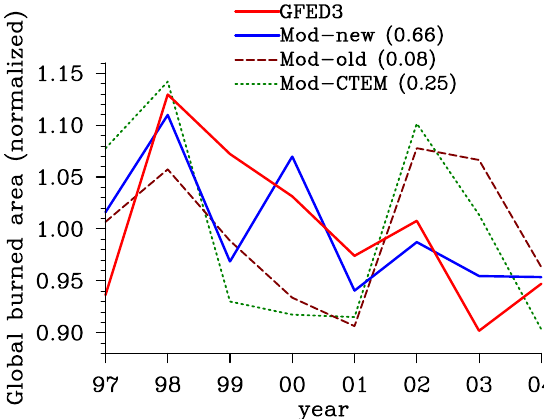
Fig. 13. Annual global burned area normalized by the mean for 1997–2004 from GFED3 and CESM1 simulations with different fire parameterizations. The numbers in brackets denote temporal correlation between GFED3 and